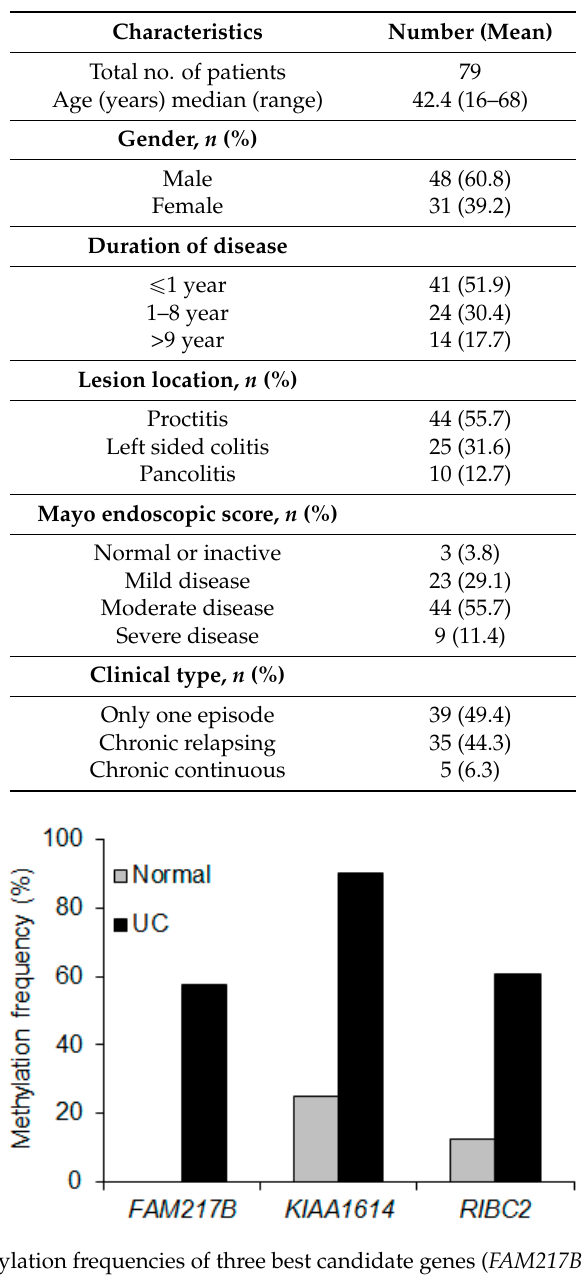
Figure 2. DNA methylation frequencies of three best candidate genes ( FAM217B , KIA1614 and RIBC2 ) in UC samples ( n = 79) and normal colon (NC) ( n = 8).